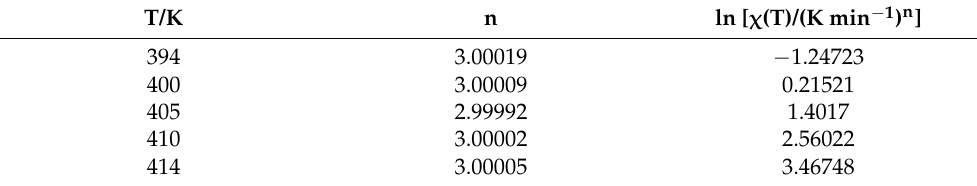
Figure 3. Arrhenius plots of the heating function. Circles and squares represent, respectively, ln χ ( T ) and ln χ ( T )/ n values; dash lines are corresponding least square fits. Solid line is plotted by substitut- ing the correct values of E and A into Equation (15). Least square fit to the solid line yields E = 106.7 kJ mol − 1 .